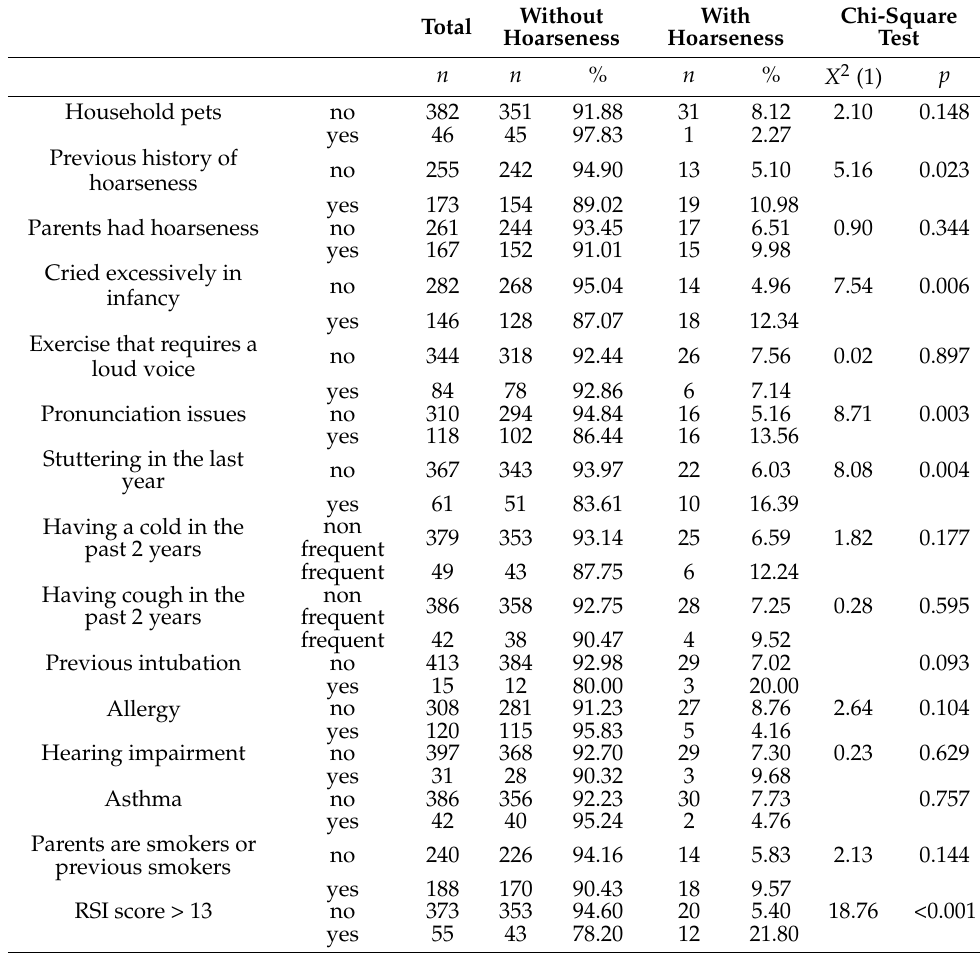
Table 3. Distribution of risk factors of hoarseness and estimated risk of hoarseness in relation to these risk factors.